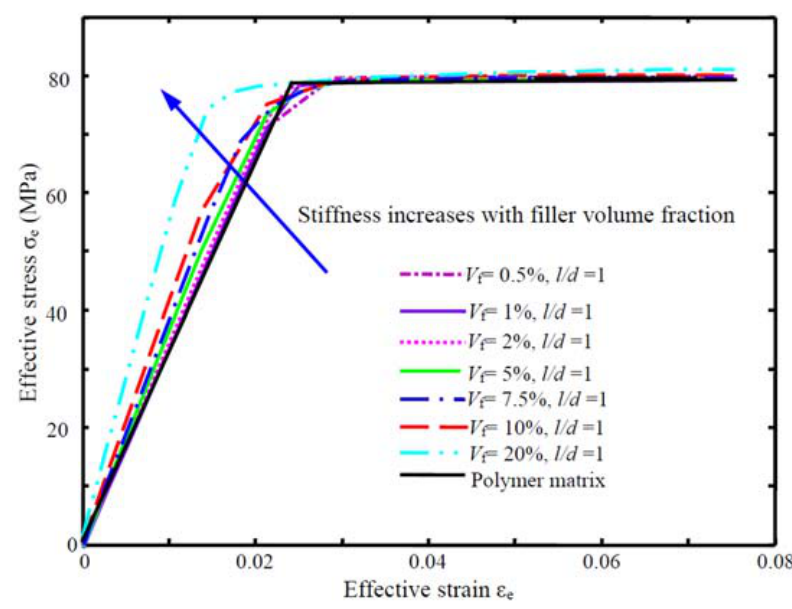
Figure 6. Effective stress-strain σ e - ε e diagram of the PNCs with the clay-particle aspect ratio ρ = 1 ( plane-strain, case I).